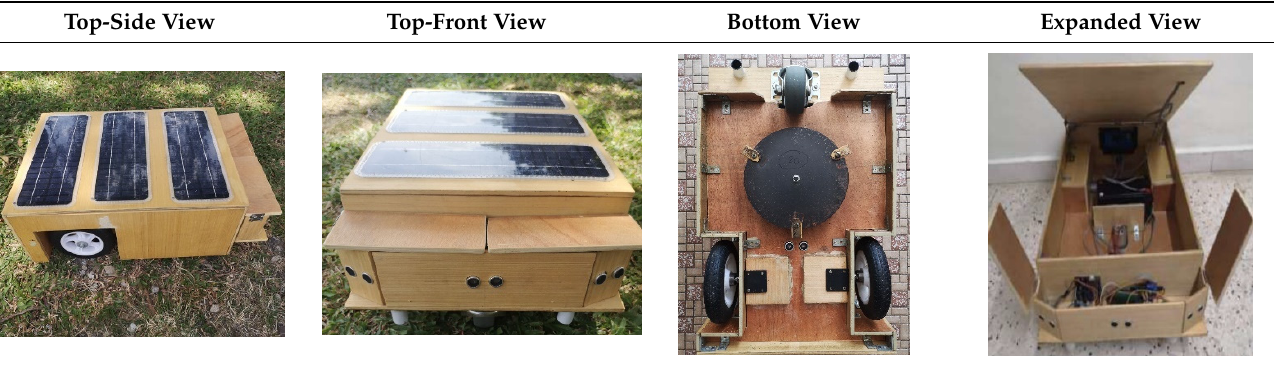
Table 23. Pictures of the prototype lawnmower.